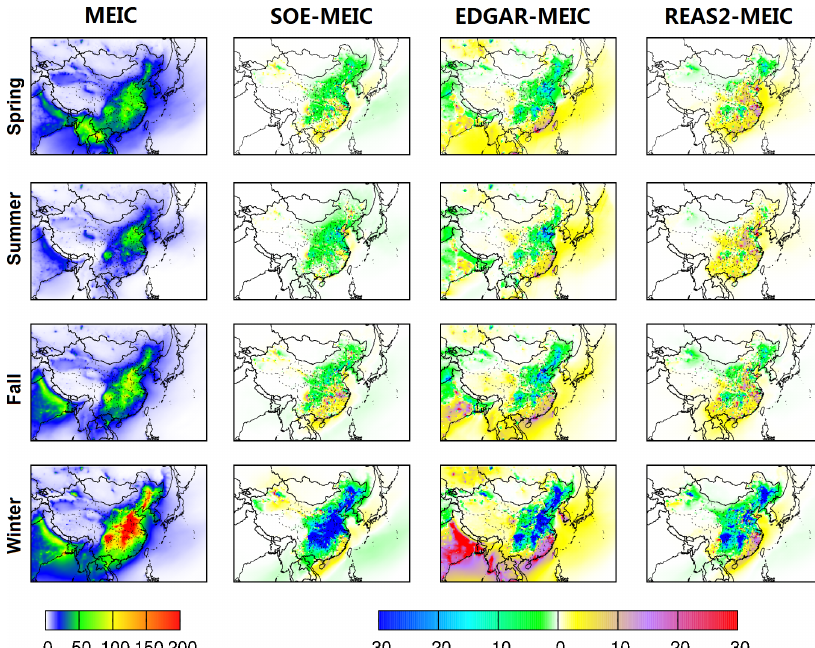
Figure 5. Spatial differences of model-predicted seasonal averaged PM 2 . 5 concentrations (in the horizontal panels) with different inventories (in the vertical panels). Units areµgm − 3 . In the first column, white indicates zero, while blue, green, yellow, and red mean concentrations from low to high. The color bars for the other three columns are same; white indicates zero and blue and green mean values less than zero, while yellow, purple, and red mean values larger than